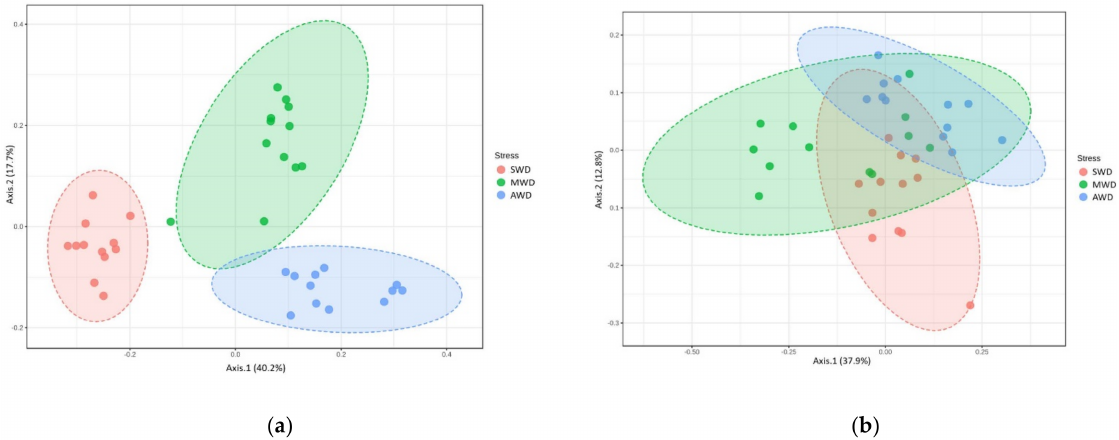
Figure 7. Principal Coordinate Analysis (PCoA) based on Bray–Curtis dissimilarity metrics, showing the distance in the fungal communities among irrigation regimes (SWD: severe water deficit, MWD: moderate water deficit, and AWD: absence of water deficit) at ( a ) 6-month and ( b ) 12-month sampling times in the bulk soil.